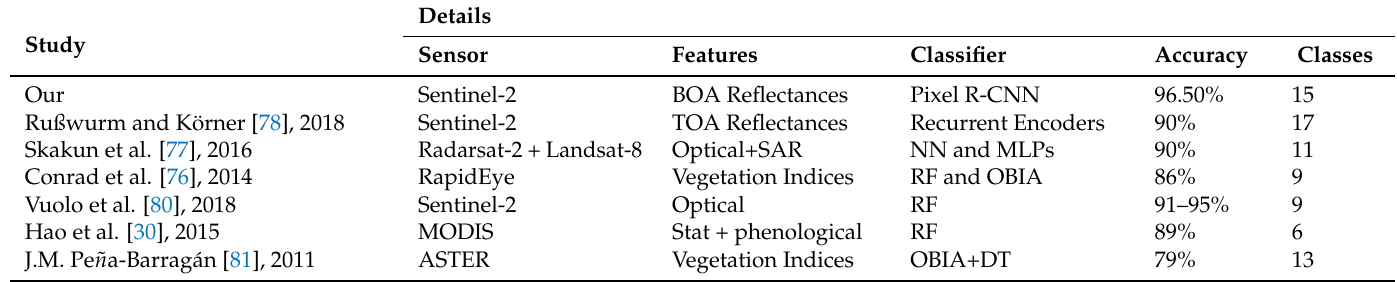
Table 5. An overview and performance of recent